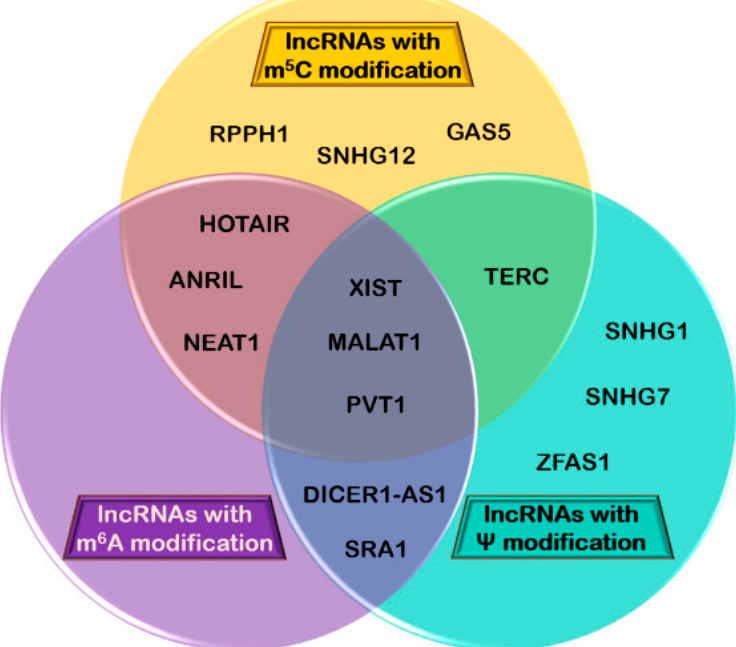
Figure 3. Venn diagram illustrating the overlap between different lncRNAs carrying m6A, m5C, ψ modifications.